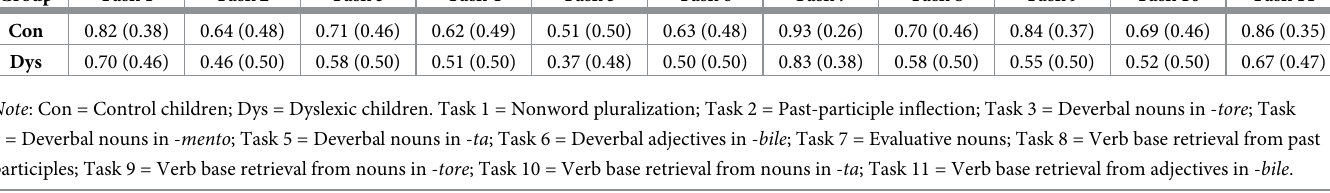
Table 6. General mean accuracy (SDs) in all morphological tasks.